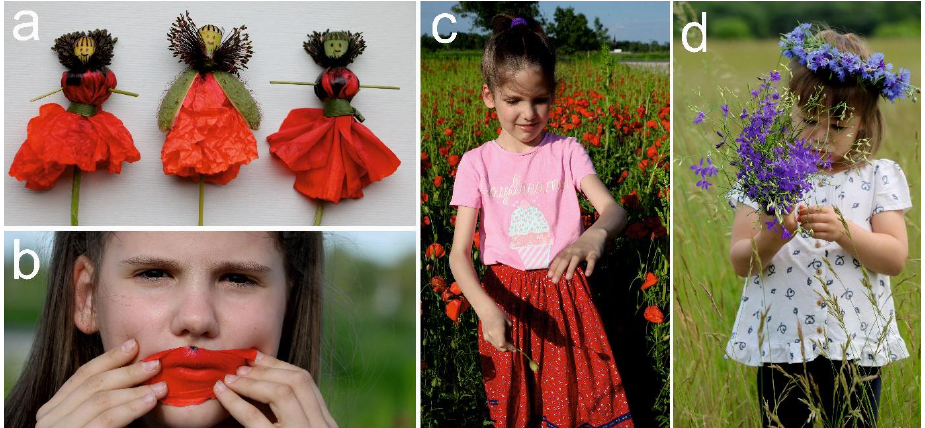
Figure 7. Animated scenes with old- fashioned children’s toys: ( a ) puppets made from poppy flower; ( b ) snapping poppy petals on the lips; ( c ) snapping a poppy bud on the back of the hand (Mosonmagyaróvár, NW Hungary, 2019); ( d ) a cornflower wreath and a bunch of larkspur (Halászi, NW Hungary, 2022) (Photographs by Gyula Pinke).